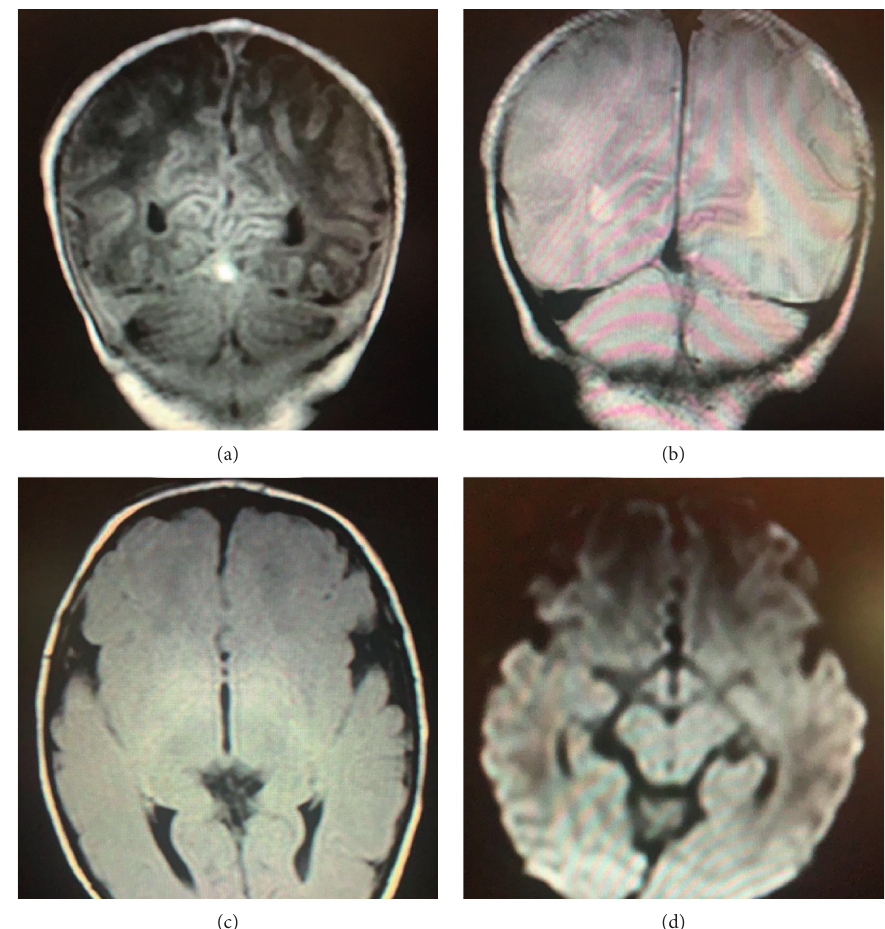
Figure 1: Coronal view of the brain. (a) T1-weighted, (b) T2-weighted (c), flair, and (d) diffusion-weighted. No abnormalities were